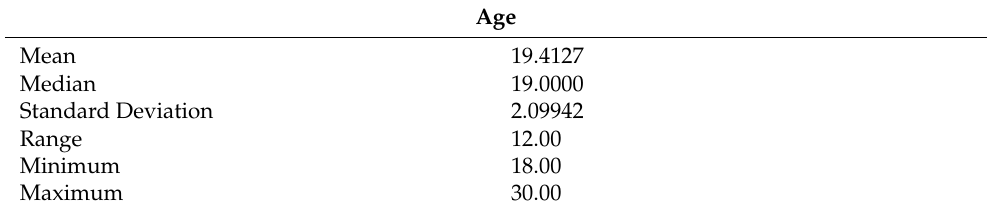
Table 2. Variable age: statistics.